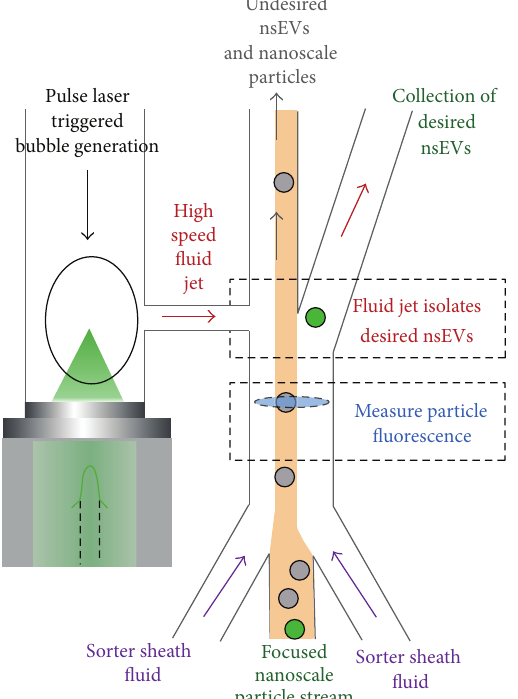
Figure 5: PLACS nsEV sorter schematic. Single nsEVs with desired fluorescence properties, for example, binding by nsEV surface marker- and cell type surface marker-specific fluorescent Abs, are isolated from the bulk plasma nanoscale particle population by high speed fluid jets. These fluid jets are generated by picoliter scale bubbles that are triggered by pulsed laser-induced cavitation. The PLACS sorting module sorts nanoparticles at rates ( ∼ 30,000/sec) comparable to those for state-of-the-art flow cytometers while providing the advantage of being able to isolate individual nsEVs from the overall particle population. Conventional flow cytometers entrap sorted nsEVs in nanoliter scale liquid droplets; droplets of this size typically encase multiple nsEVs and prevent high purity enrichment of individual nsEVs from the bulk plasma nanoscale particle